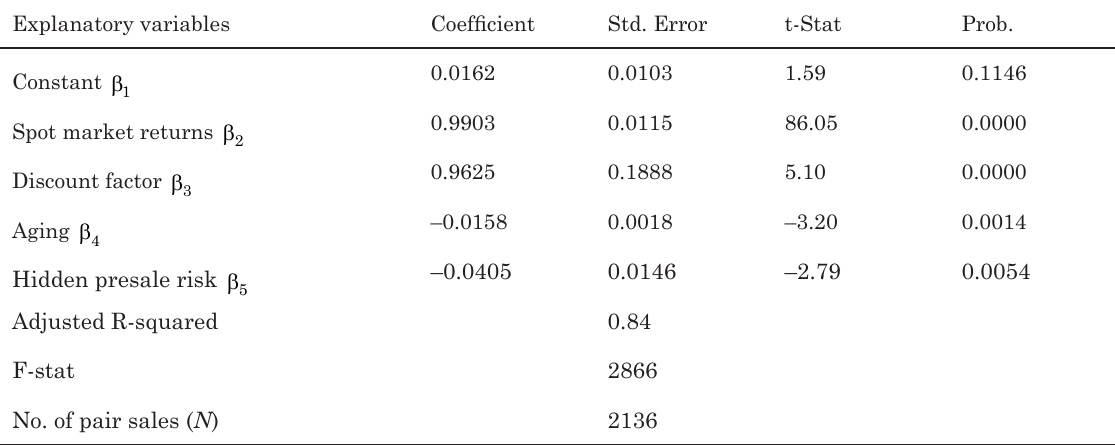
table 2. oLs estimates of the improved fsIt on the housing